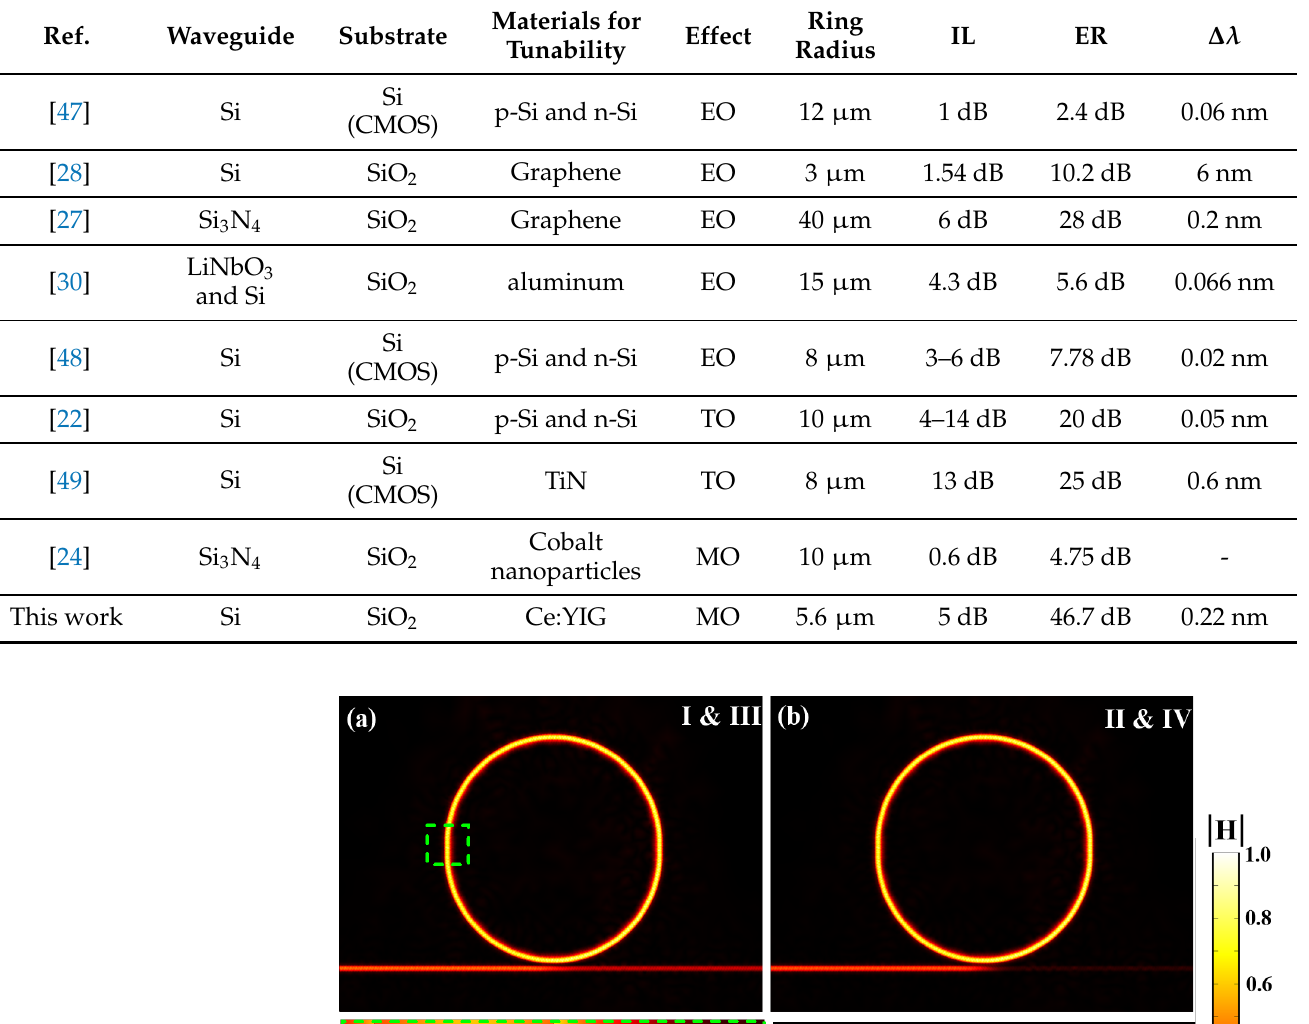
Table 1. Features comparison among the optical effects in MRR-based modulators. Ref.